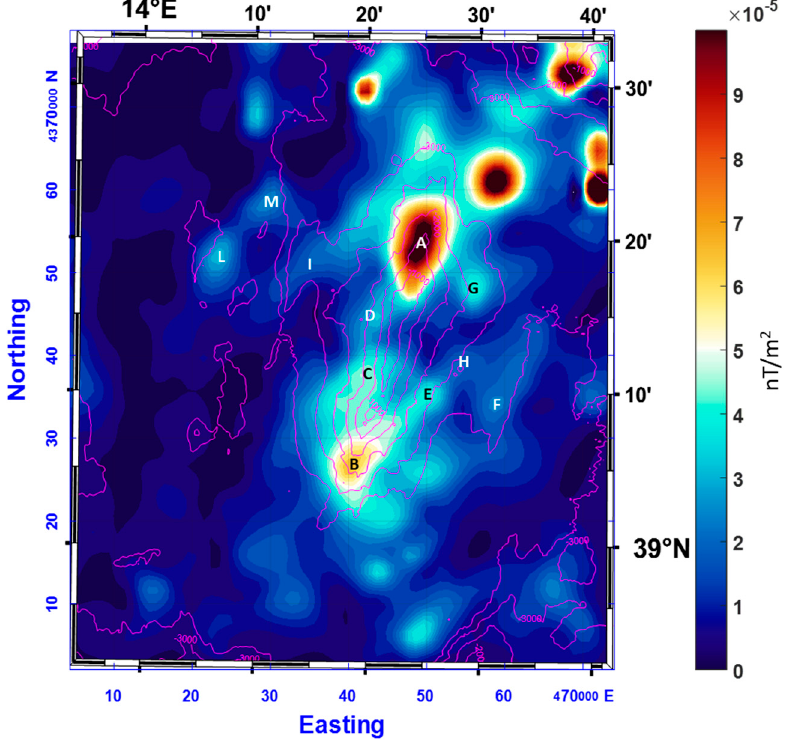
Figure 15. L -transform of the aeromagnetic anomalies continued downward to sea level in the area of Marsili Seamount. The bathymetry is shown with magenta contours. Letters identify magnetic anomalies described in the text.